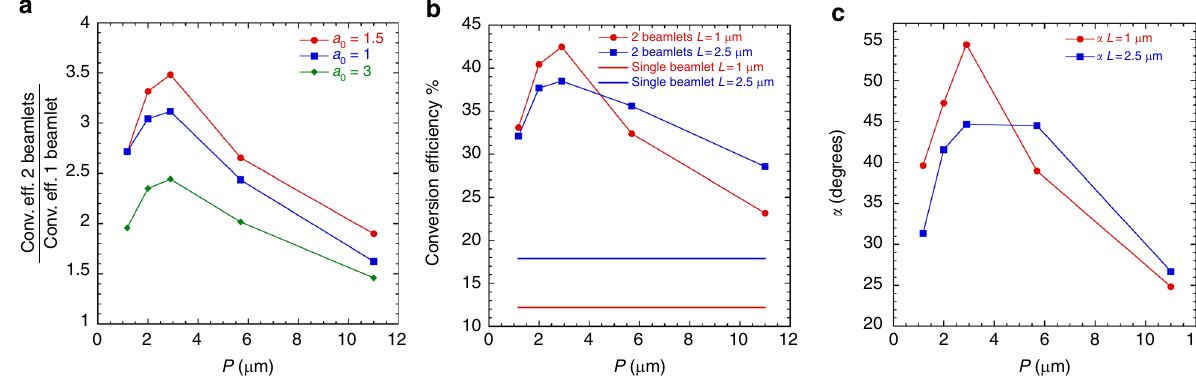
Fig. 5 Parametric beamlet interference. Parametric study of beamlet interference for different laser intensities and pre-plasma scale-lenghts. a Conversion ef fi ciency incremental factor as function of the interference period P for laser intensities corresponding to a 0 = 1, a 0 = 1.5 and a 0 = 3. b Parametric study of laser-to-electron energy conversion ef fi ciency for different pre-plasma scale-length L as function of P . The red bulleted line and straight line refer to conversion ef fi ciency for 2 and single beamlet irradiation and L = 1 μ m. The blue bulleted line and straight line refer to conversion ef fi ciency for 2 and single beamlet irradiation and L = 2.5 μ m. As expected, higher conversion ef fi ciency is found with longer pre-plasma scale-length for single beamlet interaction as well as multi-beamlet for large values of P . However, for P < 5.9 μ m higher conversion ef fi ciency is found for shorter pre-plasma scale-length and this relationship is well reproduced by c the trend of the average modulation angle α for the two scale-length cases, showing a similar trend compared to